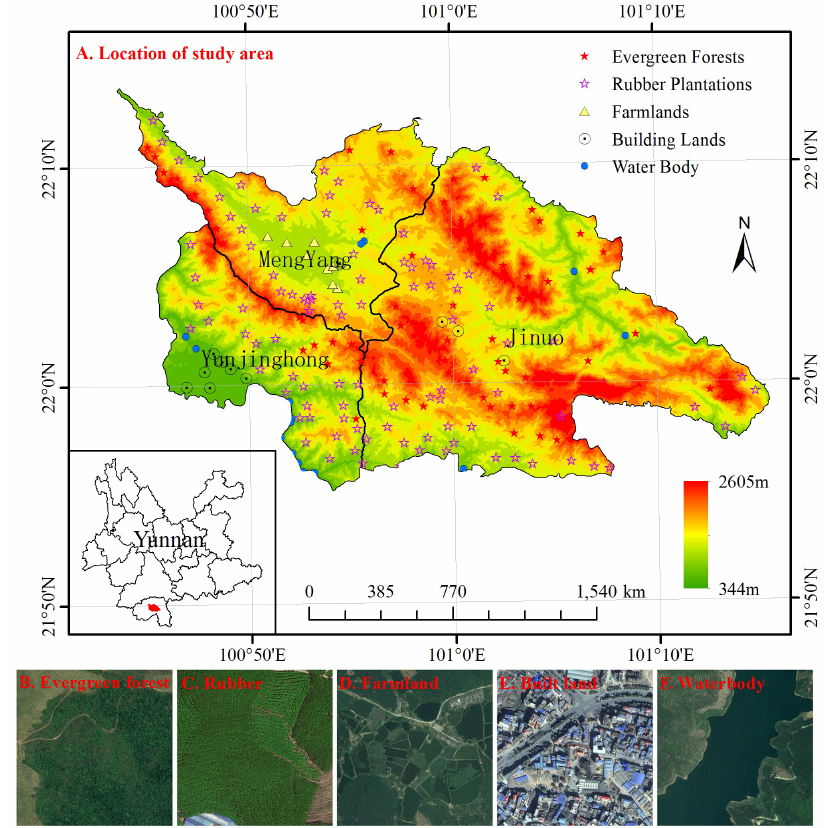
Figure 1. The study area location and samples for algorithm training and result verification. ( A ) is the location of three towns (Mengyang, Jinuo, and Yunjinghong) in Jinghong County Xishuangbanna, Yunnan, China, and spatial distributions for samples of five typical land cover types including evergreen forests, rubber plantations, farmlands, built-lands, and water bodies. They are created from geo-referenced field photos and Google Earth High quality imagery; ( B – F ) are high-resolution images of five typical land cover types from Google Earth.